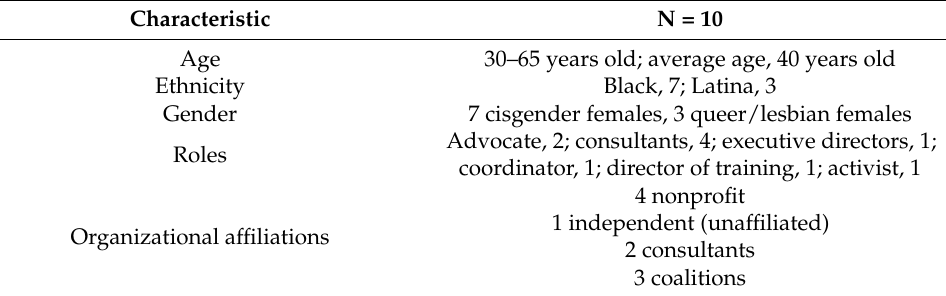
Table 1. Participant